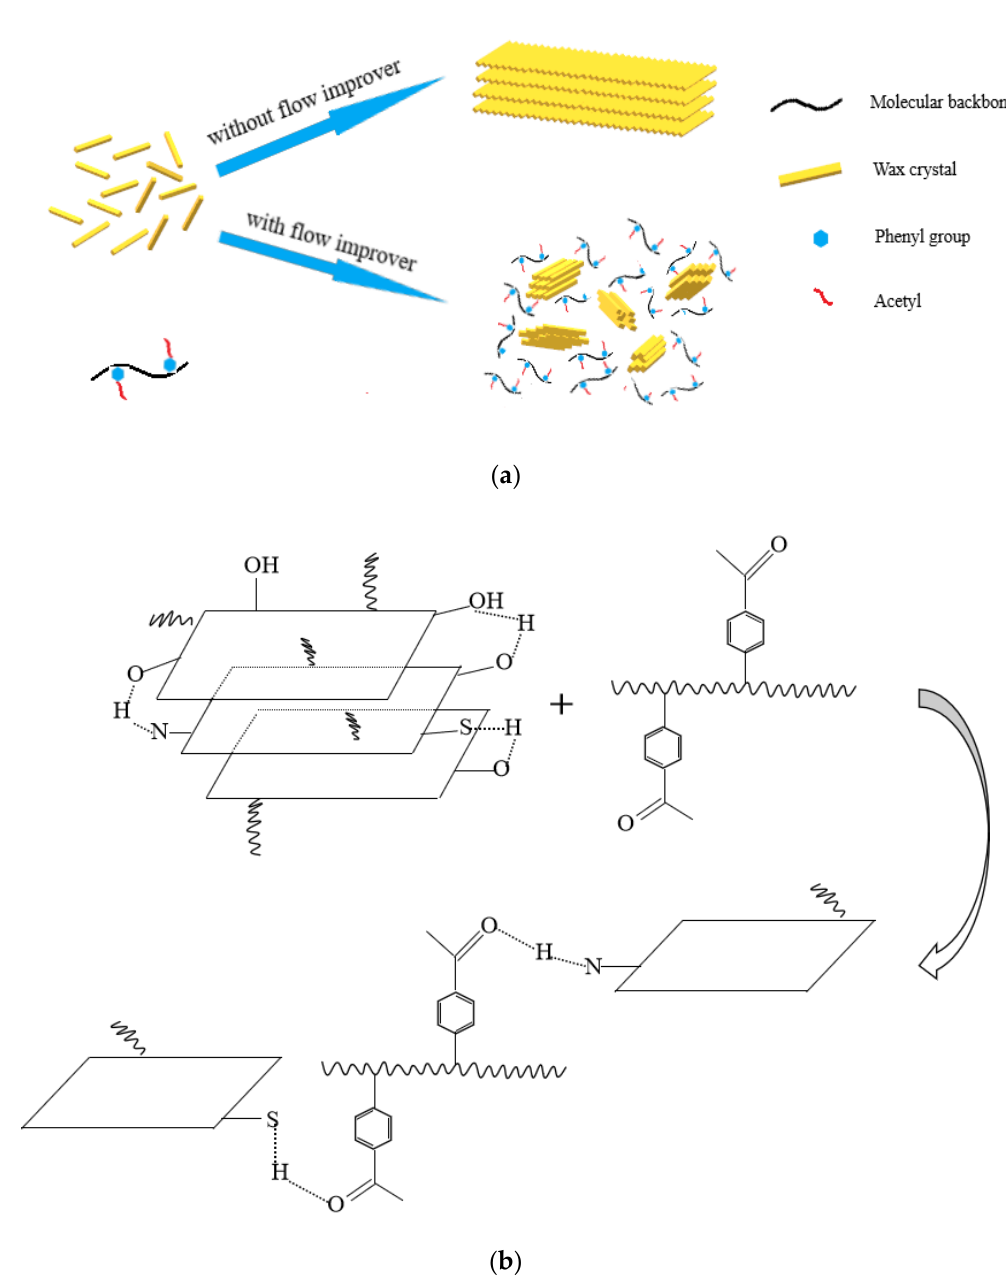
Figure 8. Mechanism of modified polystyrene on the formation of ( a ) the growth mode and ( b ) aggregates formed by overlapping planes wax crystals.